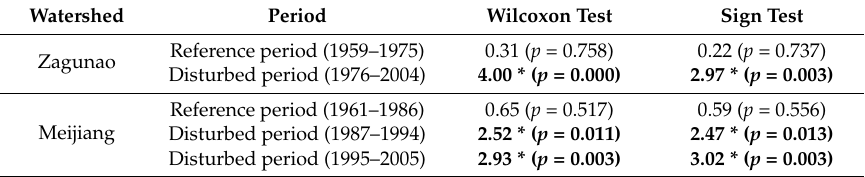
Table 5. Wilcoxon test and Sign test for significance of differences in predicted dry season runoff and observed dry season runoff in reference and disturbed periods